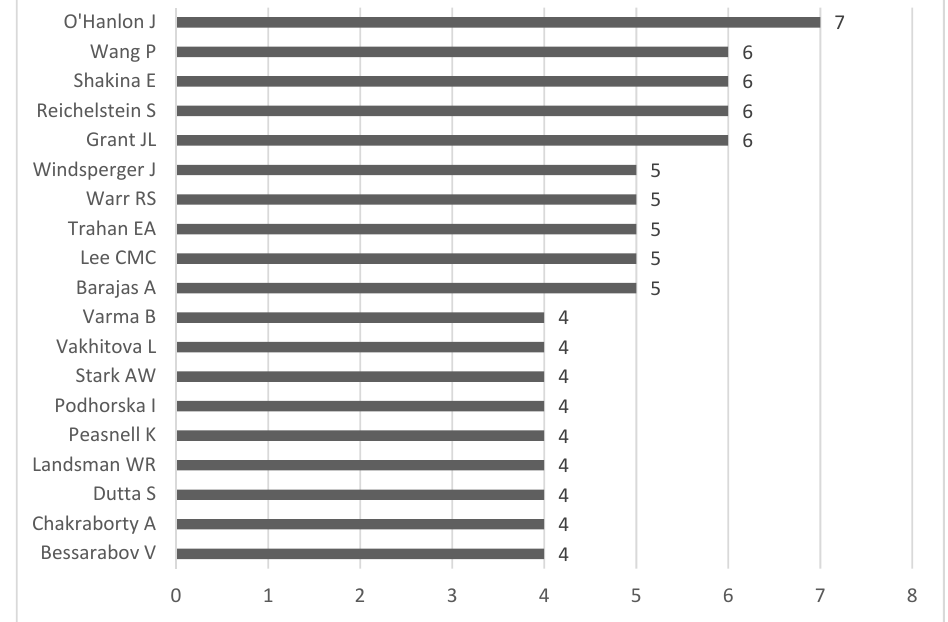
Figure 4. Leading Authors Contributing to EVA Research (Minimum of Four Articles).